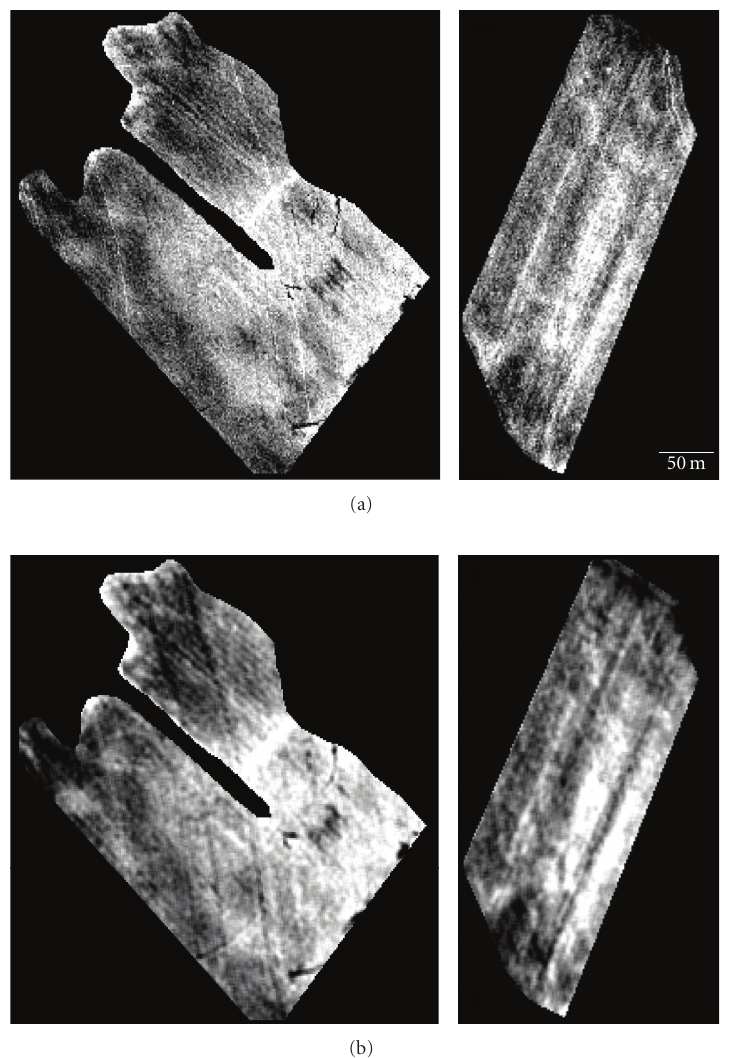
Figure 3: Maps of predicted soil carbon content calculated from (a) unsmoothed imagery (1-pixel data extraction) and (b) spatially smoothed imagery (9-pixel data extraction). Two of the six sampled fields are depicted here, with Temple 3 on the left and Schrader on the right. Predicted values ranged from 0.4% (black) to 2.5%